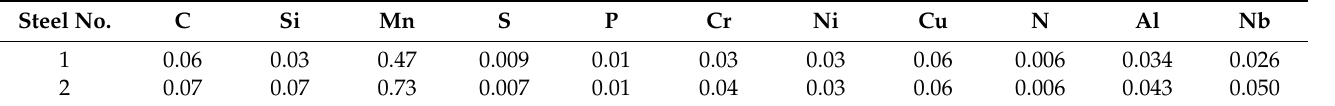
Table 1. Chemical composition of the investigated steels, wt.%.